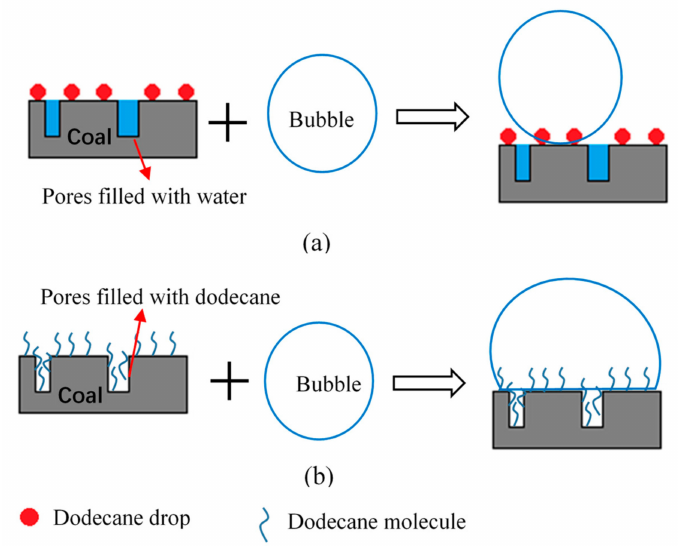
Figure 7. Schematic representation of the enhancing mechanism of the gaseous dodecane pretreatment. ( a ) Conventional flotation and ( b ) gaseous pretreatment